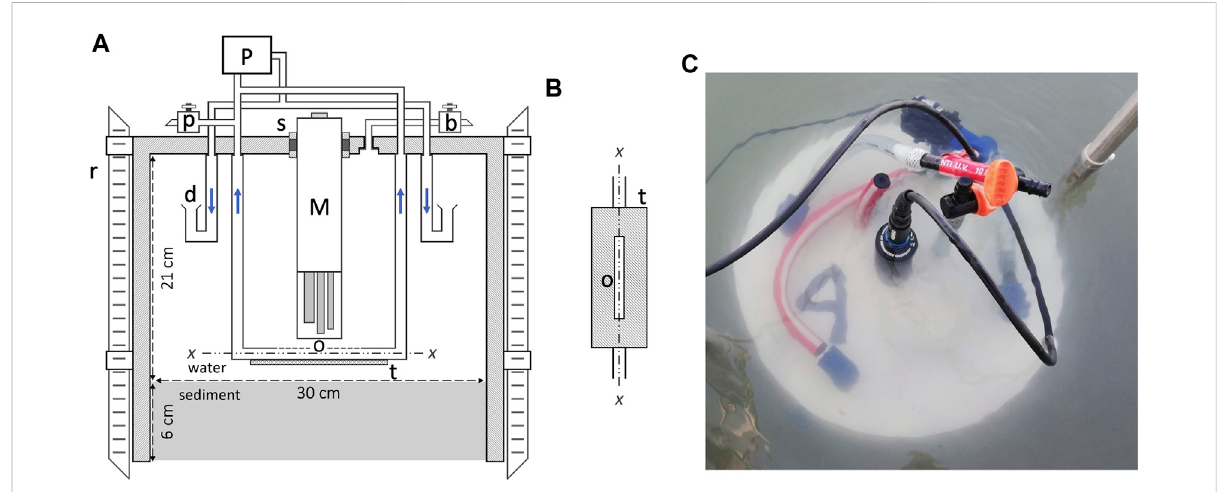
FIGURE 2 (A) :schematicdrawingoftheSODchamber(notinscale):pump(P);funnel-shaped fl owdiffusers(d);pump-primingcock(p);airbleedcock(b); multiprobe (M); centimeter steel rods, integral with the chamber (r); composite sleeve in PVC and Plastazote ® (s); rectangular suction opening (o); PVC shielding plate (t). (B) : detail of the suction opening (o). (C) : photo of a chamber being immersed in the water column before deployment in the